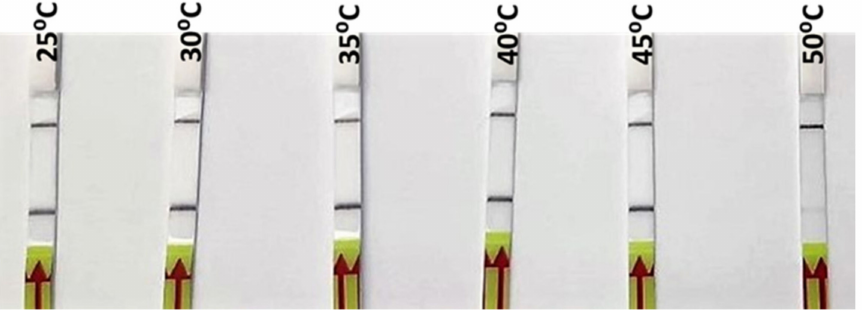
Figure 3. Lateral flow strips showing RPA-LFA results for the different incubation temperatures tested (25, 30, 35, 40, 45, and 50 ◦ C).